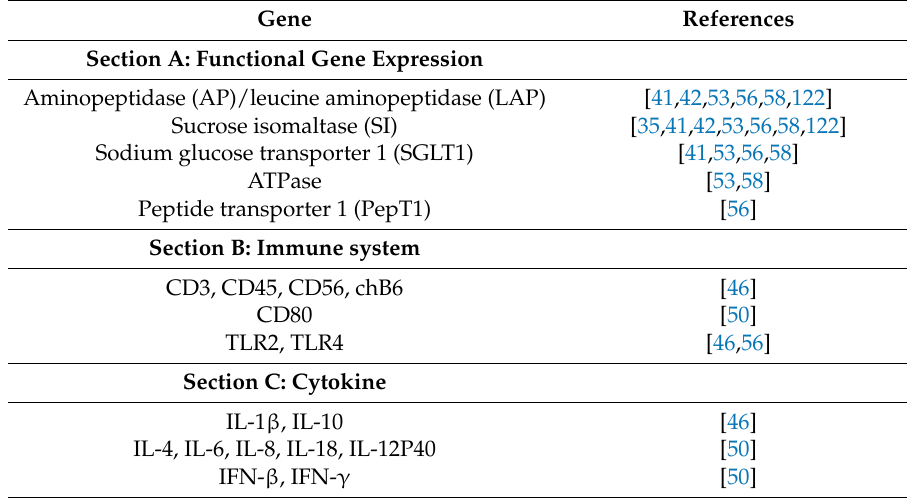
Table 2. Functional gene expression and immune system response in the in ovo prebiotic administration